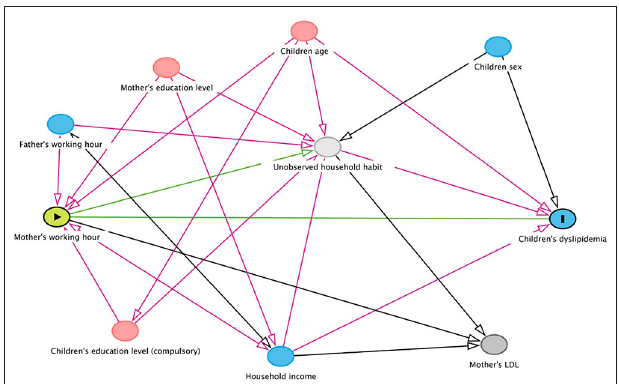
FIGURE 2 | A diagram showing the possible association between mother’s working hours and children’s